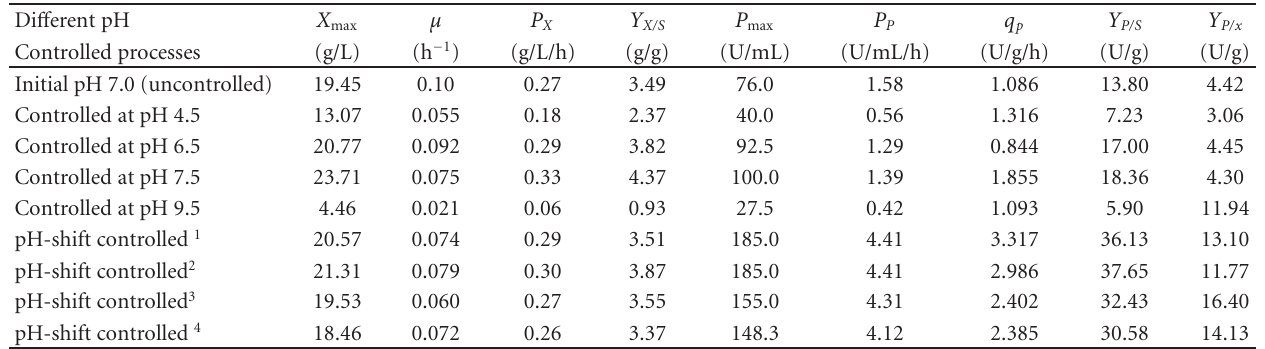
Table 1: The parameters of the batch fermentation of X. nematophila YL001 under various pH controlled